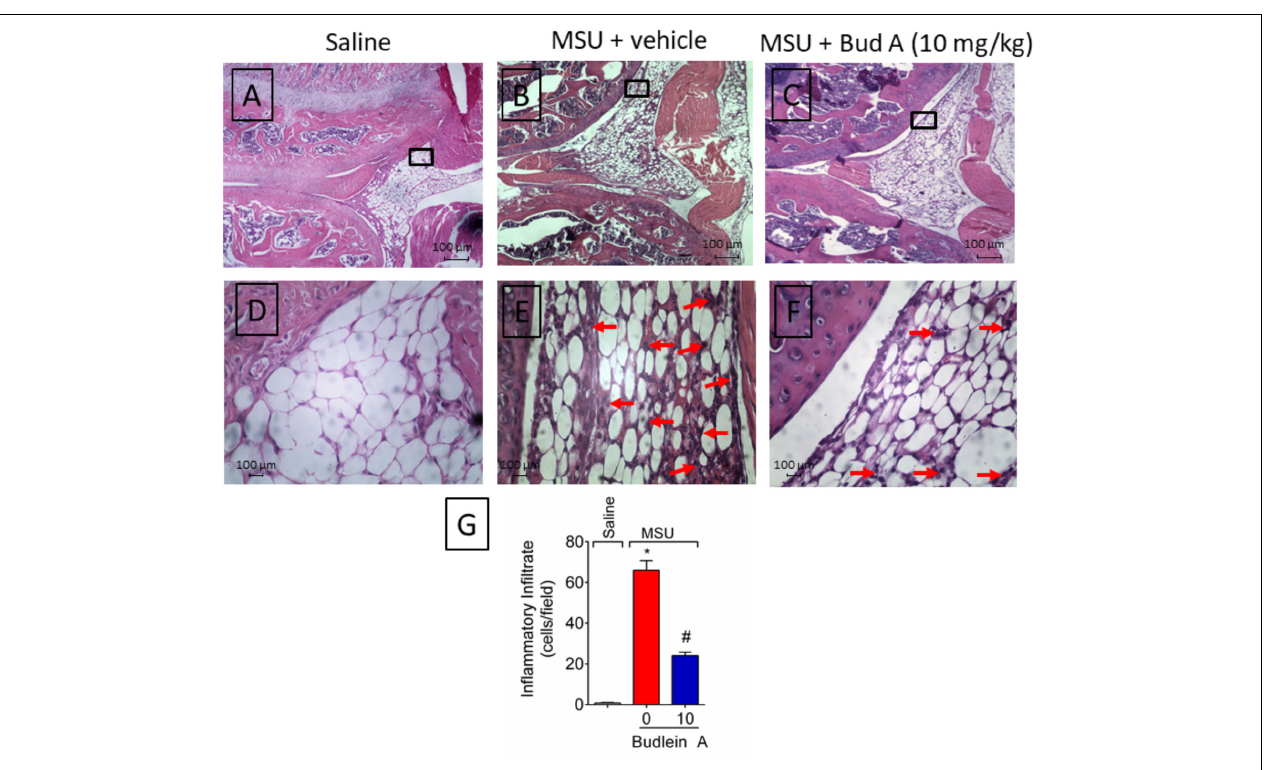
FIGURE 3 | Budlein A reduces MSU-induced synovitis. Fifteen hours after the injection of MSU crystals, knee joint was dissected for histopathological analysis by H&E staining using a light microscope [Original magnification 10 × (A–C) and 40 × (D–F) ]. The representative total score of inflammatory cells counted in the 40 × objective is presented in panel (G) . ∗ p < 0.05 vs. saline group; # p < 0.05 vs. 0 mg/kg group, one-way ANOVA followed by post hoc